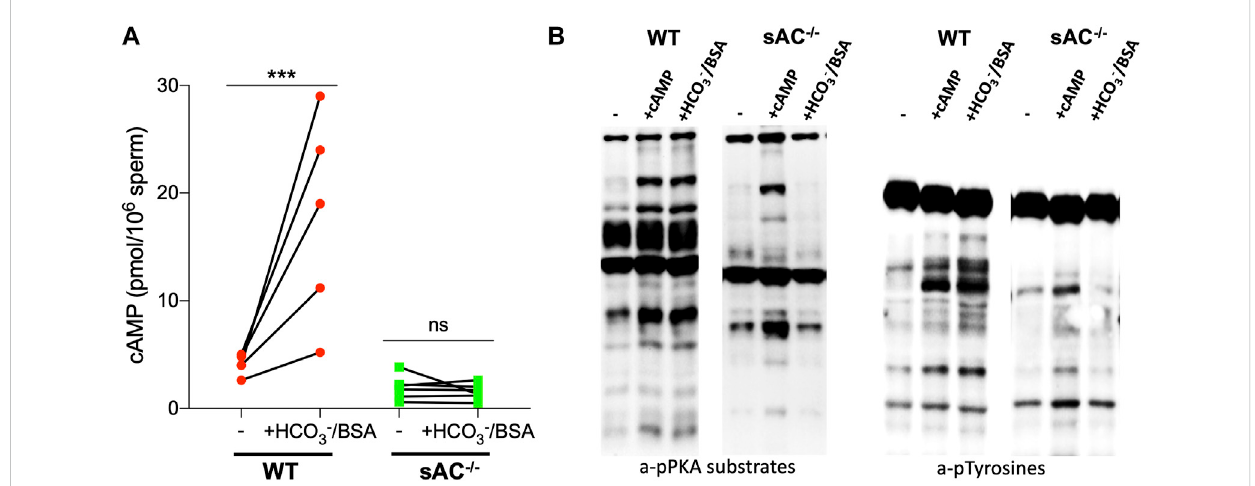
FIGURE 1 (A) Intracellular cAMP levels in WT (red circles) and sAC − / − (green squares) sperm after incubation for 15 min in the presence of 0.5 μ M IBMX in non- capacitating ( − ) or capacitating (+HCO 3 − /BSA) media. Individual replicates indicated by symbols, N = 5. Ratio paired Student ’ s t test was performed between indicated conditions: *** p < 0.001, ns (non-signi fi cant). (B) Western blot analysis using anti-pPKA substrates and anti-pTyrosines antibodies. Sperm were incubated for 60 min in the absence ( − ) or presence of 0.5 mM 8Br-cAMP and 0.5 μ M IBMX (+cAMP) or 20 mM HCO 3 − and 5 mg/mL BSA (+HCO 3 −